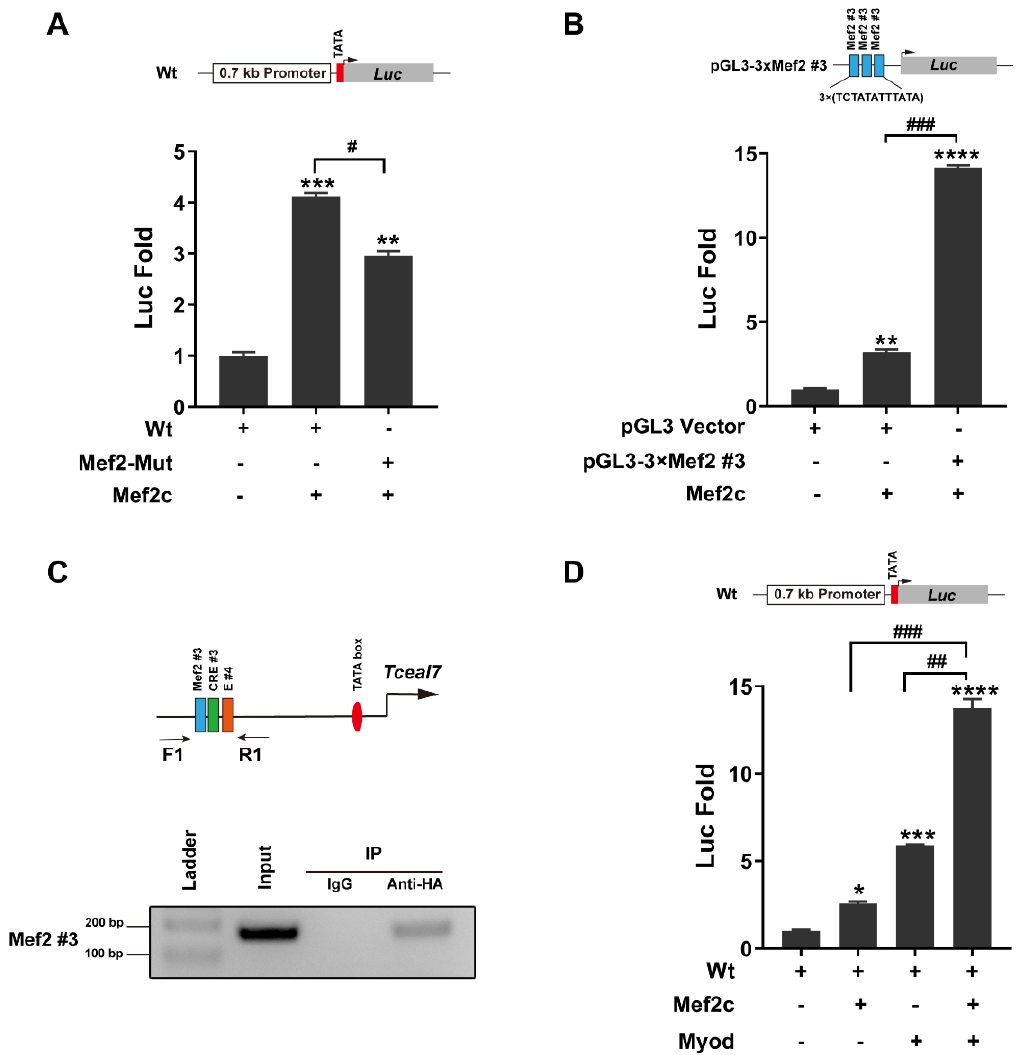
Figure 2. Transactivation of Tceal7 by Mef2c. ( A ) The Tceal7 0.7 kb promoter reporter (Wt or Mef2-Mut) and Mef2c were cotransfected into C2C12 cells, and analyzed with a dual-luciferase assay system. The Wt reporter is transactivated by Mef2c up to four-fold, while the transactivation of the Mef2-Mut reporter is attenuated to three-fold. ** p < 0.01 and *** p < 0.001, comparison with the first group (Wt reporter). # p < 0.05. ( B ) Top panel, schematic diagram of the pGL3-3 × Mef2 #3 luciferase reporter, which harbors a multimerized (3 × ) Mef2 #3 motif of the Tceal7 promoter. The pGL3-3 × Mef2 #3 luciferase reporter is transactivated by Mef2c up to 14-fold, while the transactivation of the pGL3 vector is around 3-fold in C2C12 cells. ** p < 0.01 and **** p < 0.001, comparison with first group (pGL3 vector). ### p < 0.001. ( C ) Upper panel, ChIP–PCR primers (F1 and R1) are designed to amplify the Mef2#3 region specifically. The Mef2#3 region is enriched in the ChIP product with rabbit anti-HA antibodies, specifically, but not the control IgG. F1, forward primer; R1, reverse primer; input, total DNA product before immunoprecipitation. ( D ) Transactivation of the Wt reporter by Mef2c and Myod reaches up to 13.8-fold, exceeding that by Mef2c (2.6-fold) or Myod (5.9-fold) alone in NIH3T3 cells. * p < 0.05; *** p < 0.001 and **** p < 0.0001, comparison with first group (Wt reporter). ## p < 0.01 and ### p < 0.001. All Data represent mean ± SD of three independent